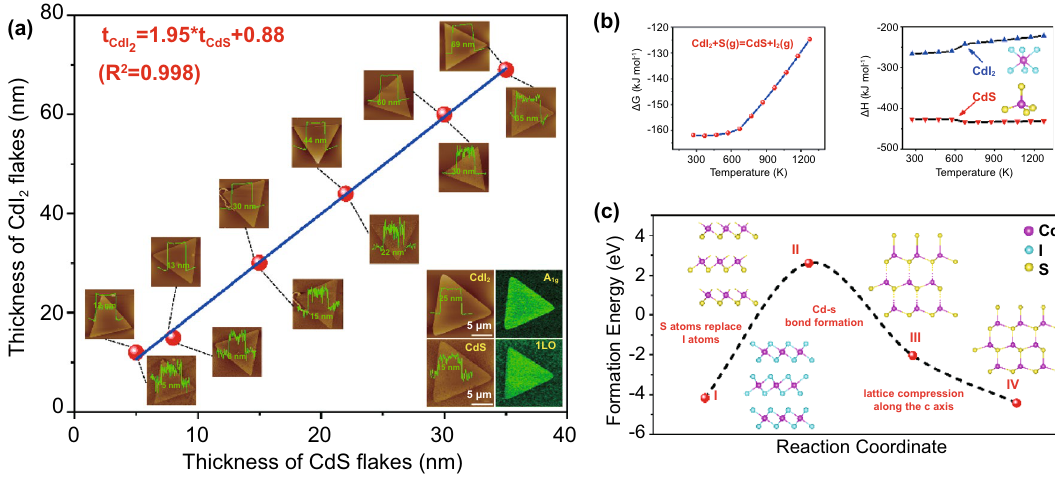
Fig. 4 The controllable sulfidation of CdI 2 flakes and corresponding conversion mechanism of CdS flakes. a The thickness of CdI 2 flakes before (AFM images above data line) and after being converted to CdS flakes (AFM images below data line). Inset: the representative AFM images and corresponding Raman intensity mapping of CdI 2 flakes and converted CdS flakes. Note that the thickness of the CdI 2 flakes was about 1.95 times higher compared to the corresponding of CdS flakes, which agrees well with the ratio of the c lattice constant between the two compounds. b , c The theory calculations and the proposed growth mechanism of CdS flakes. b Left: the calculated Gibbs free energy changes versus the tempera- ture for the chemical reaction concerning the conversion process. Right: the calculated formation enthalpy changes versus the temperature for CdI 2 and CdS. c The DFT-calculated energy profile of the possible reaction pathway for